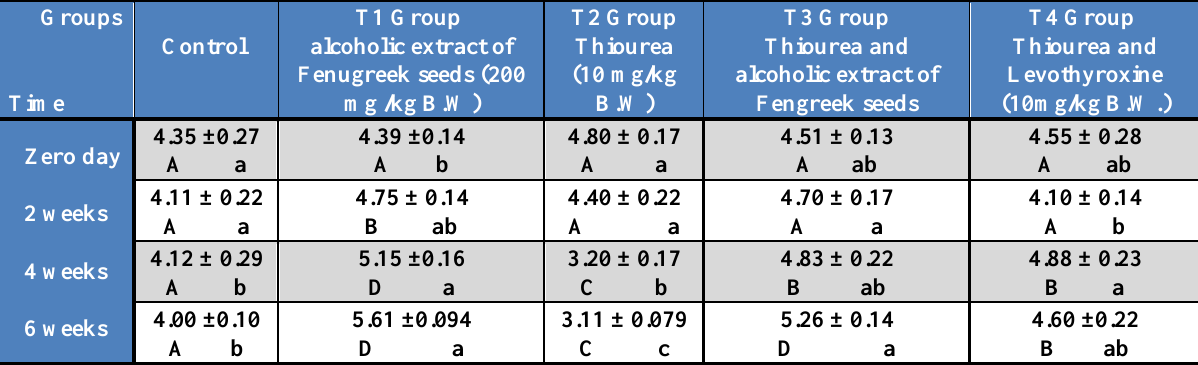
Table, 3: Effect of alcoholic extract of fenugreek seeds, thiourea and levothyroxine on (RBC) concentration (N x 10 6 cells/L) in adult male